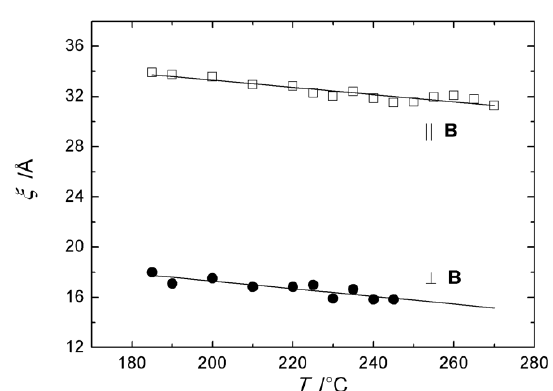
Figure 4. Longitudinal, ξ (cid:107) (open squares), and transverse, ξ ⊥ (full circles), correlation lengths as a function of the temperature in the cybotactic N phase of BCM 1a . The solid lines are linear fits to the experimental data. Reproduced from [14] with permission from The Royal Society of Chemistry.